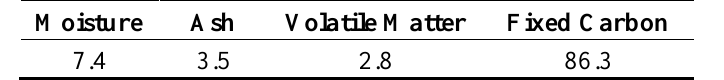
Table 4. Proximate analysis of the semi-coke (wt%, as received basis).